Question: What style of plot is this figure drawn as?
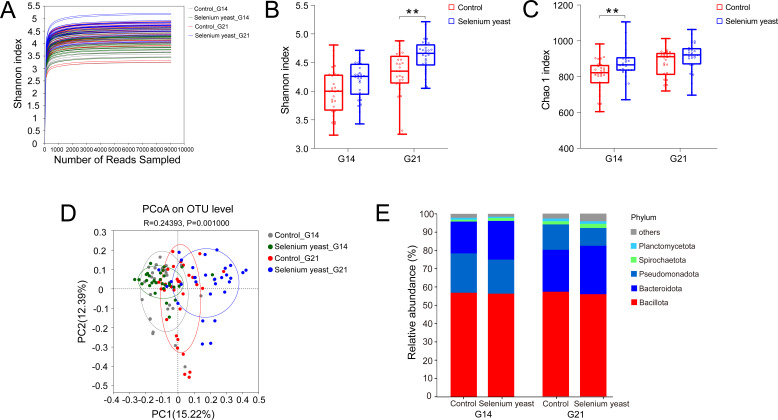
Answer: line